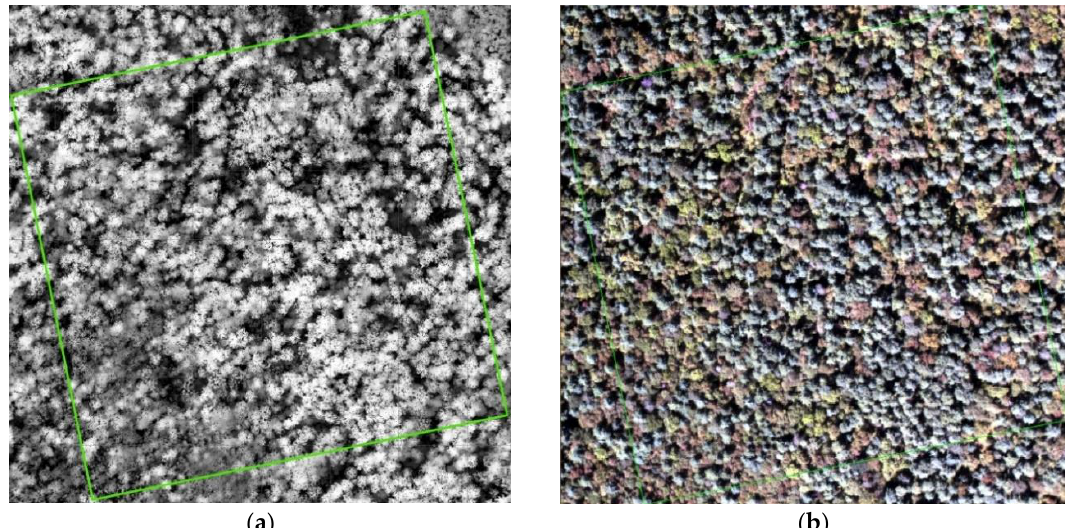
Figure 2. CHM and hyperspectral image of the plot (R: 693.6 nm; G: 533.6 nm; B: 459.7 nm). ( a ) CHM; ( b ) Hyperspectral image.